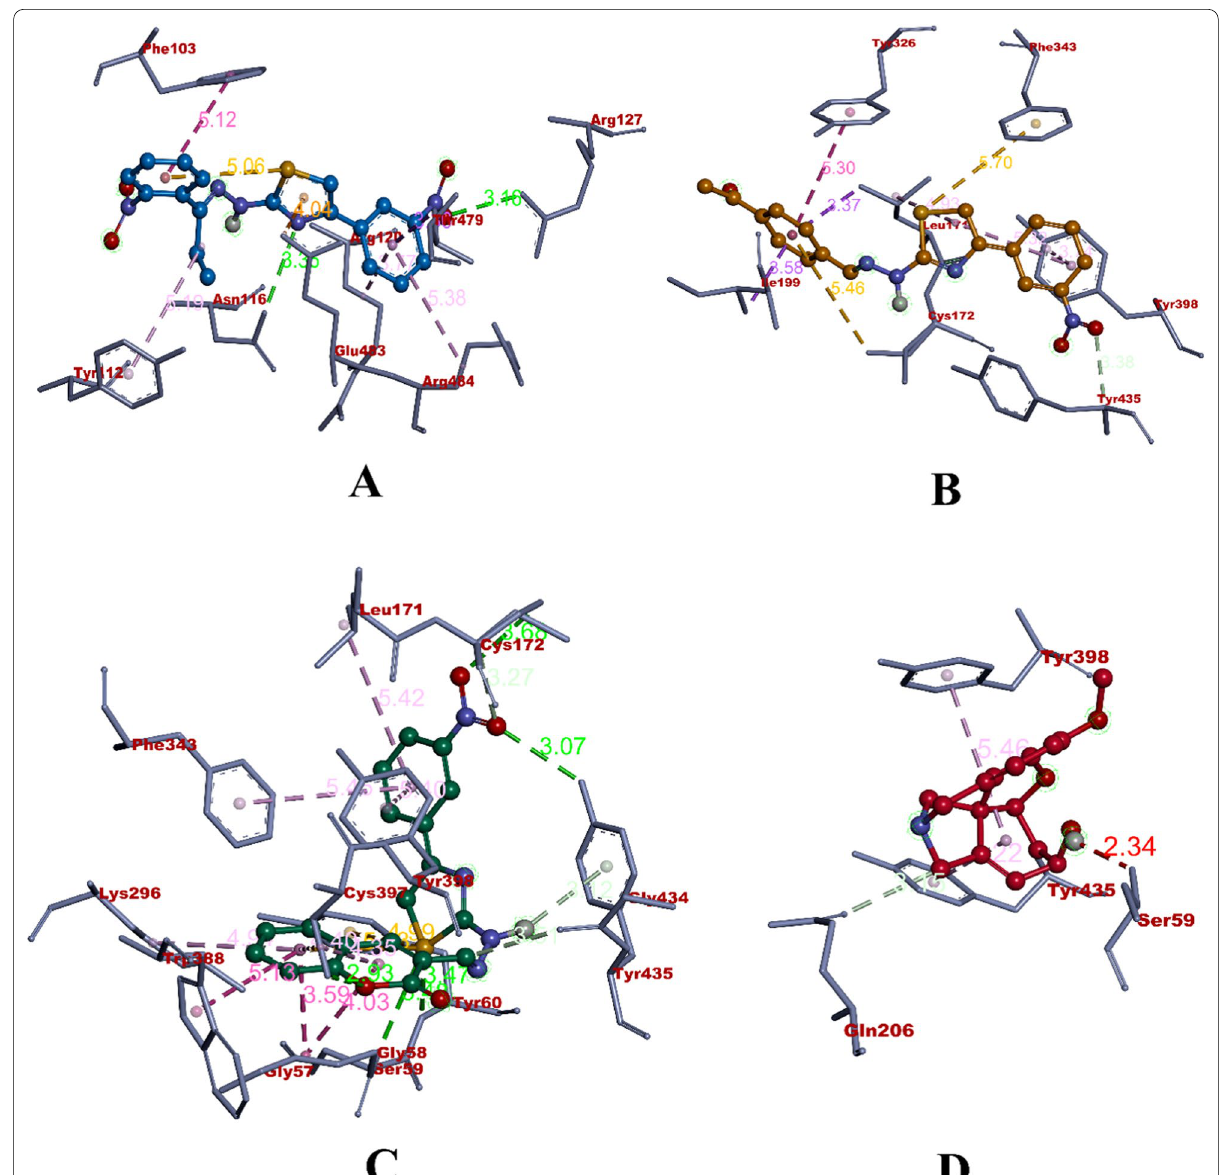
Fig. 8 Binding interactions of compounds with the protein in 3D view: A compound 13, B compound 31, C compound 33, and D Eldepryl